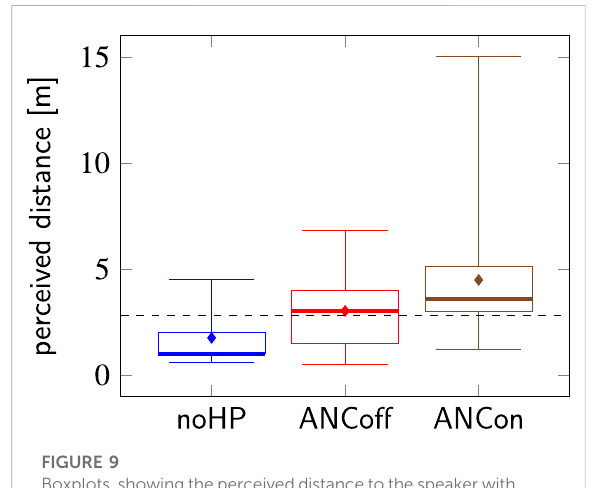
FIGURE 9 Boxplots, showing theperceiveddistancetothespeakerwith actual nearest speaker position (dashed line). Only exp.